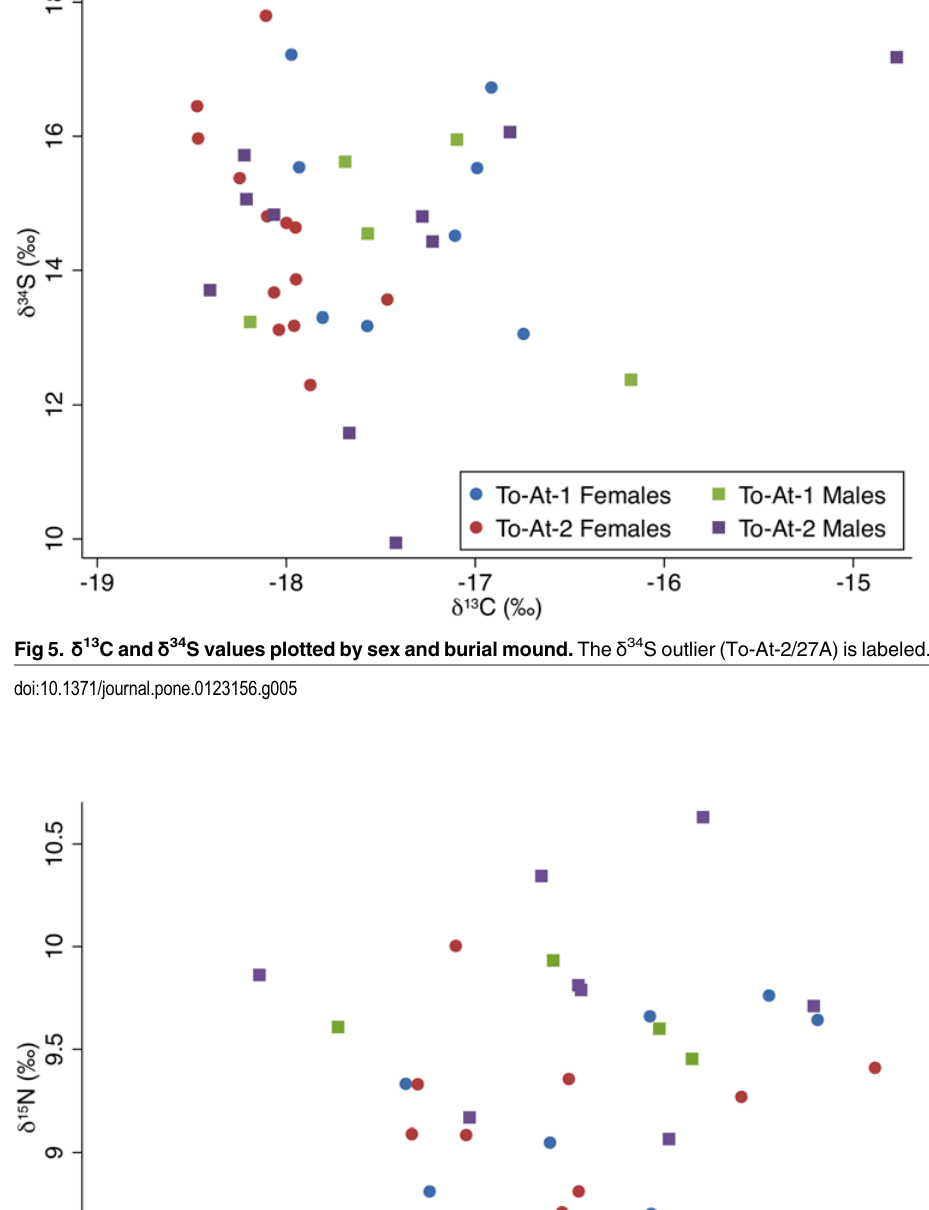
PLOS ONE | DOI:10.1371/journal.pone.0123156 March 30,